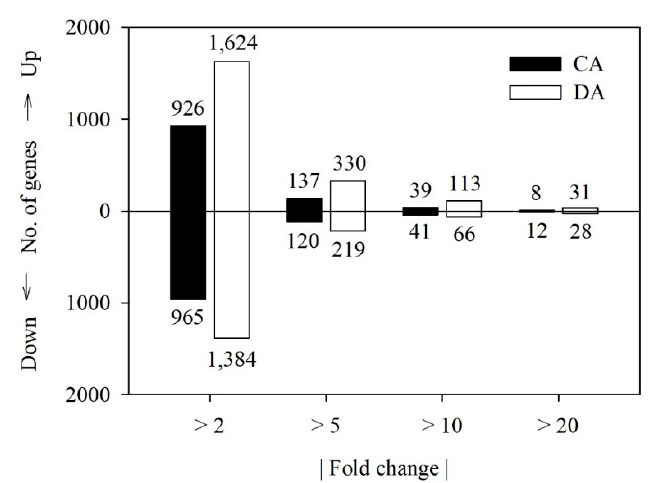
Figure 2. Number of up- and down-regulated genes with a |fold change| > 2 ( p < 0.05) in the ‘Soomee’ peach tree shoots during cold acclimation (CA) and deacclimation (DA). Fold changes during CA and DA were determined based on the FPKM values at late CA and late DA as compared to those at early and late CA, respectively.